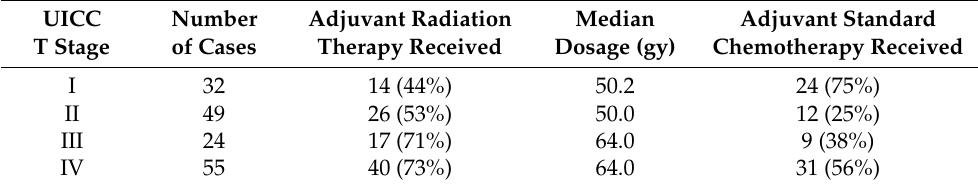
Table 2. Frequency and Intensity of Adjuvant